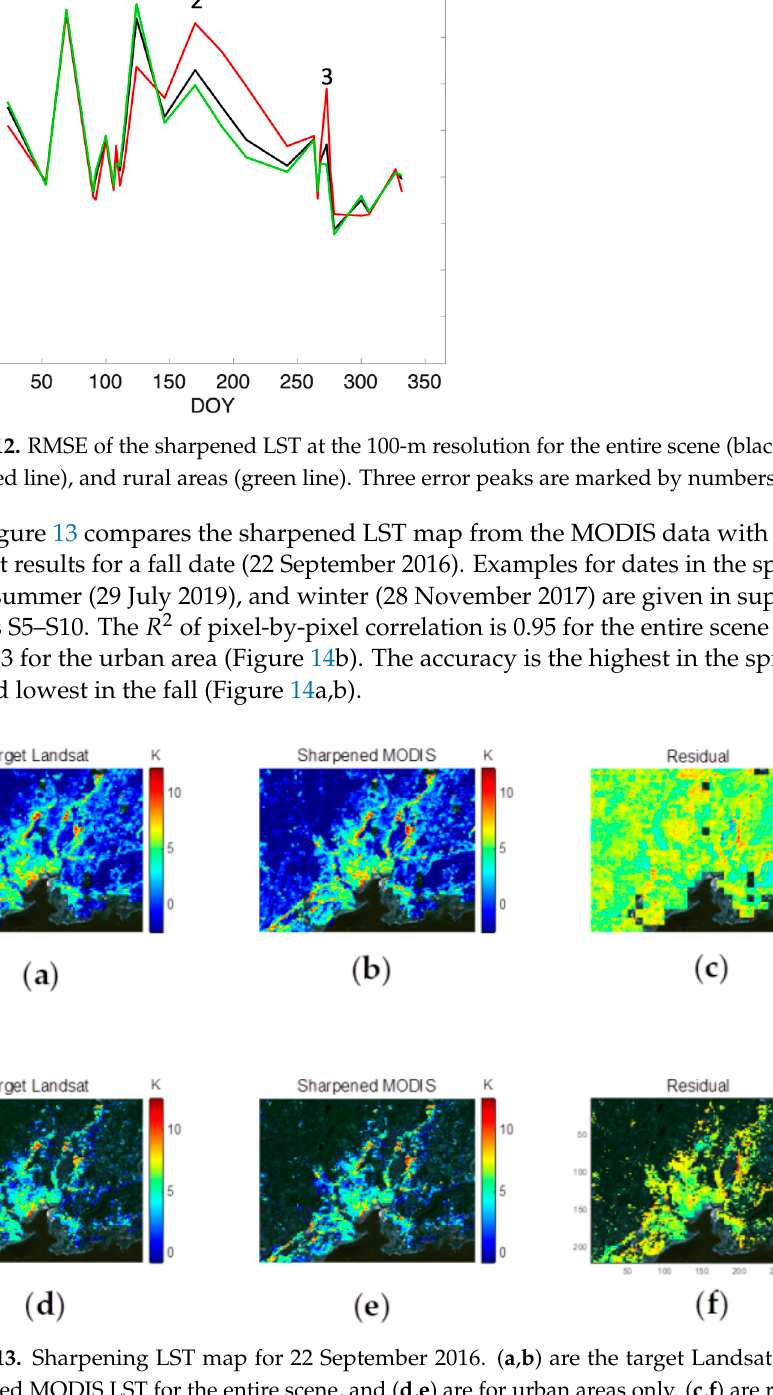
Figure 13. Sharpening LST map for 22 September 2016. ( a , b ) are the target Landsat LST and the sharpened MODIS LST for the entire scene, and ( d , e ) are for urban areas only. ( c , f ) are residual maps (sharpened MODIS minus target Landsat) for the entire scene and for urban areas, respectively.